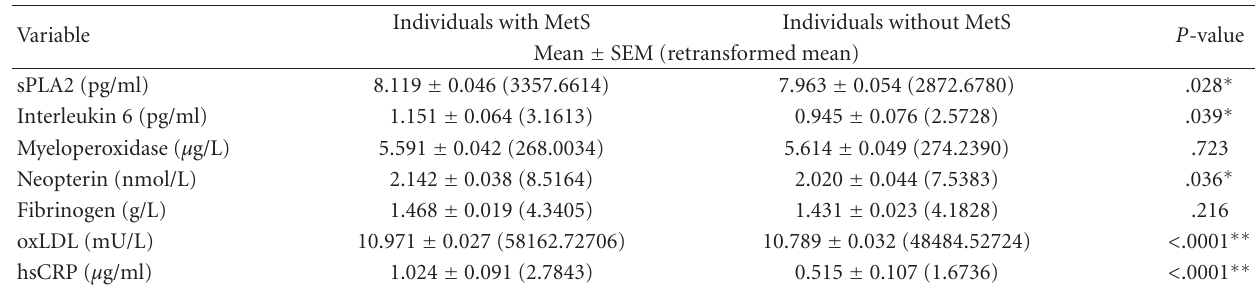
Table 3: Comparison of plasma levels of inflammatory and oxidative stress markers among subjects with and without metabolic syndrome. Individuals with Variable